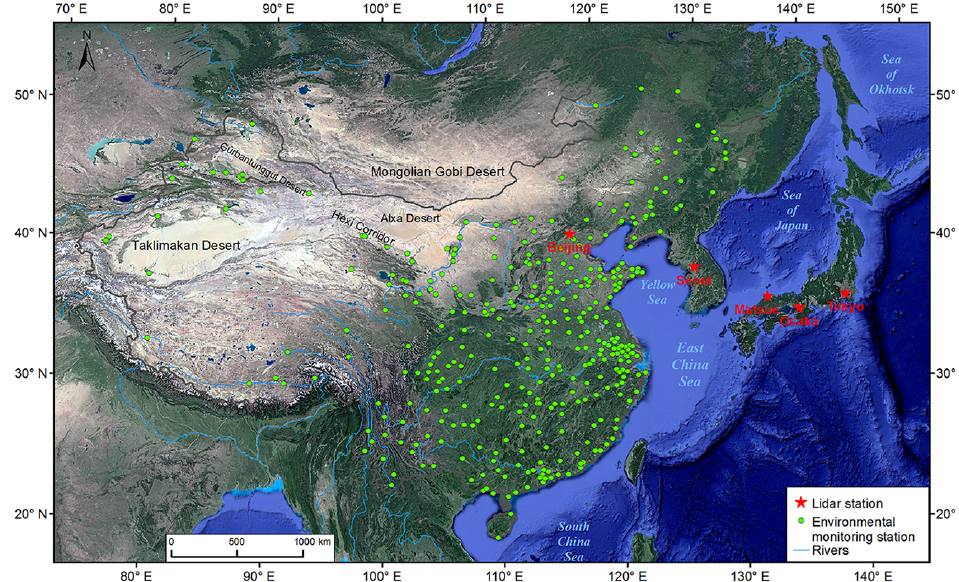
Figure 2. Location of environmental monitoring stations in the Chinese mainland and lidar monitoring stations in East